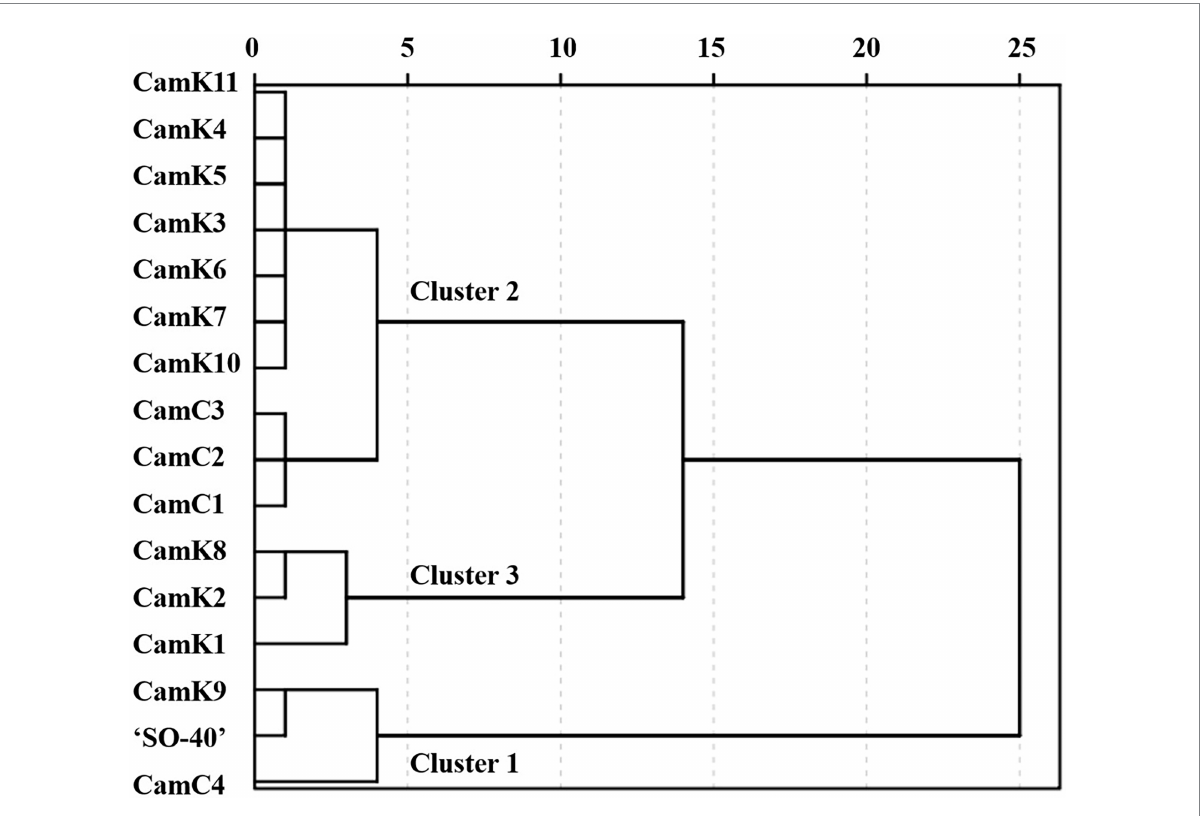
FIGURE 5 The dendrogram was constructed using the comprehensive tolerance membership values for the evaluation of shade tolerance of the 16 camelina genotypes. The camelina genotypes in Cluster 1, Cluster 2, and Cluster 3 represent the relatively shade-tolerant, medium shade-tolerant, and shade-sensitive camelina genotypes. The value of the comprehensive tolerance membership function for each camelina genotype was calculated considering the performance of each genotype under those three different shade levels (LST, MST, and HST) using the Eq.